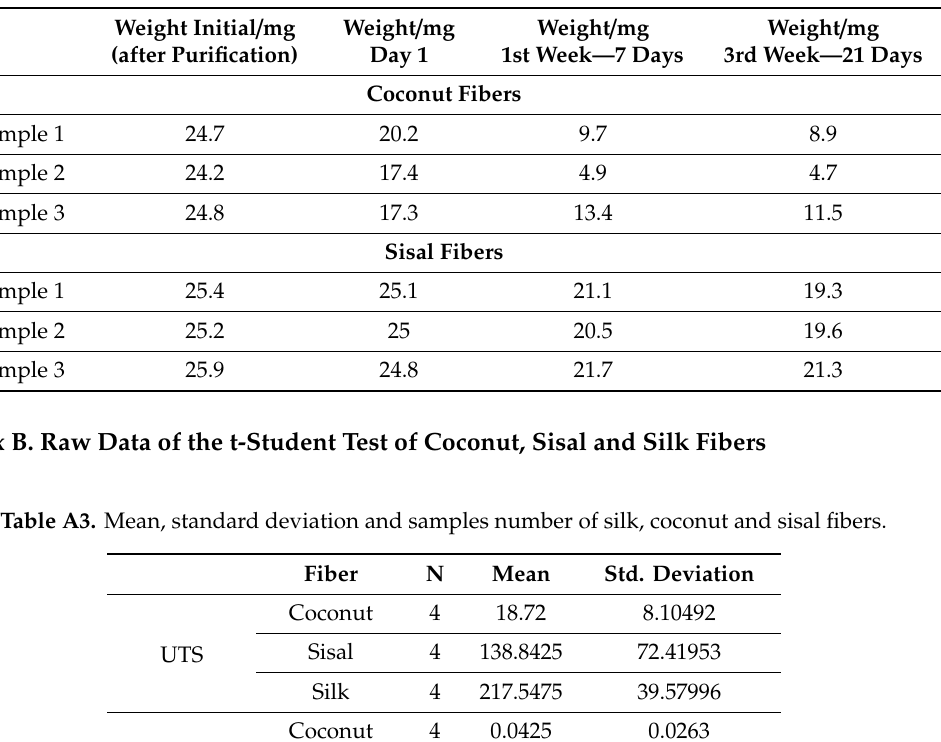
Table A2. Weight loss of fiber samples coconut and sisal in the biodegradability test.